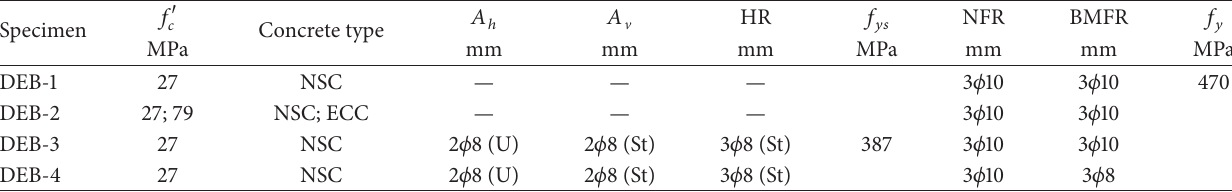
Table 2: The compressive strength and reinforcement details.